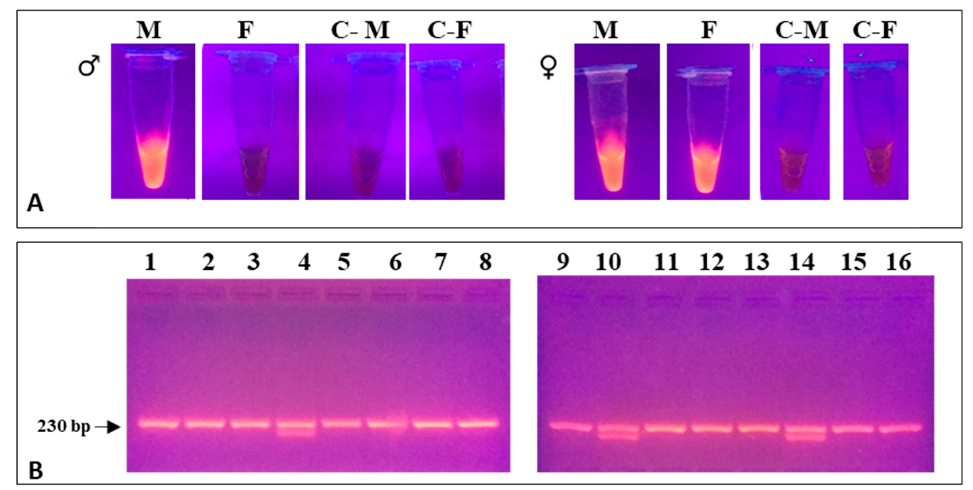
Figure 4. DNA ( A ) Fluorimetric detection of PCR products using the set of primers M and F under UV light using GelRed. Blue light gives similar results ( B ) agarose gel electrophoresis of PCR products obtained using the newly designed primers (Proc-Fw/Proc-M-Rv/Proc-F204Rv) for single-tube reaction on randomly selected samples of C. diomedea (Table 1). Line 1, 2, 3, 5, 6, 7, 8, 9, 11, 12, 13, 15, 16: male samples blood; Line 4, 10, 14: female samples blood. C- are the negative controls.